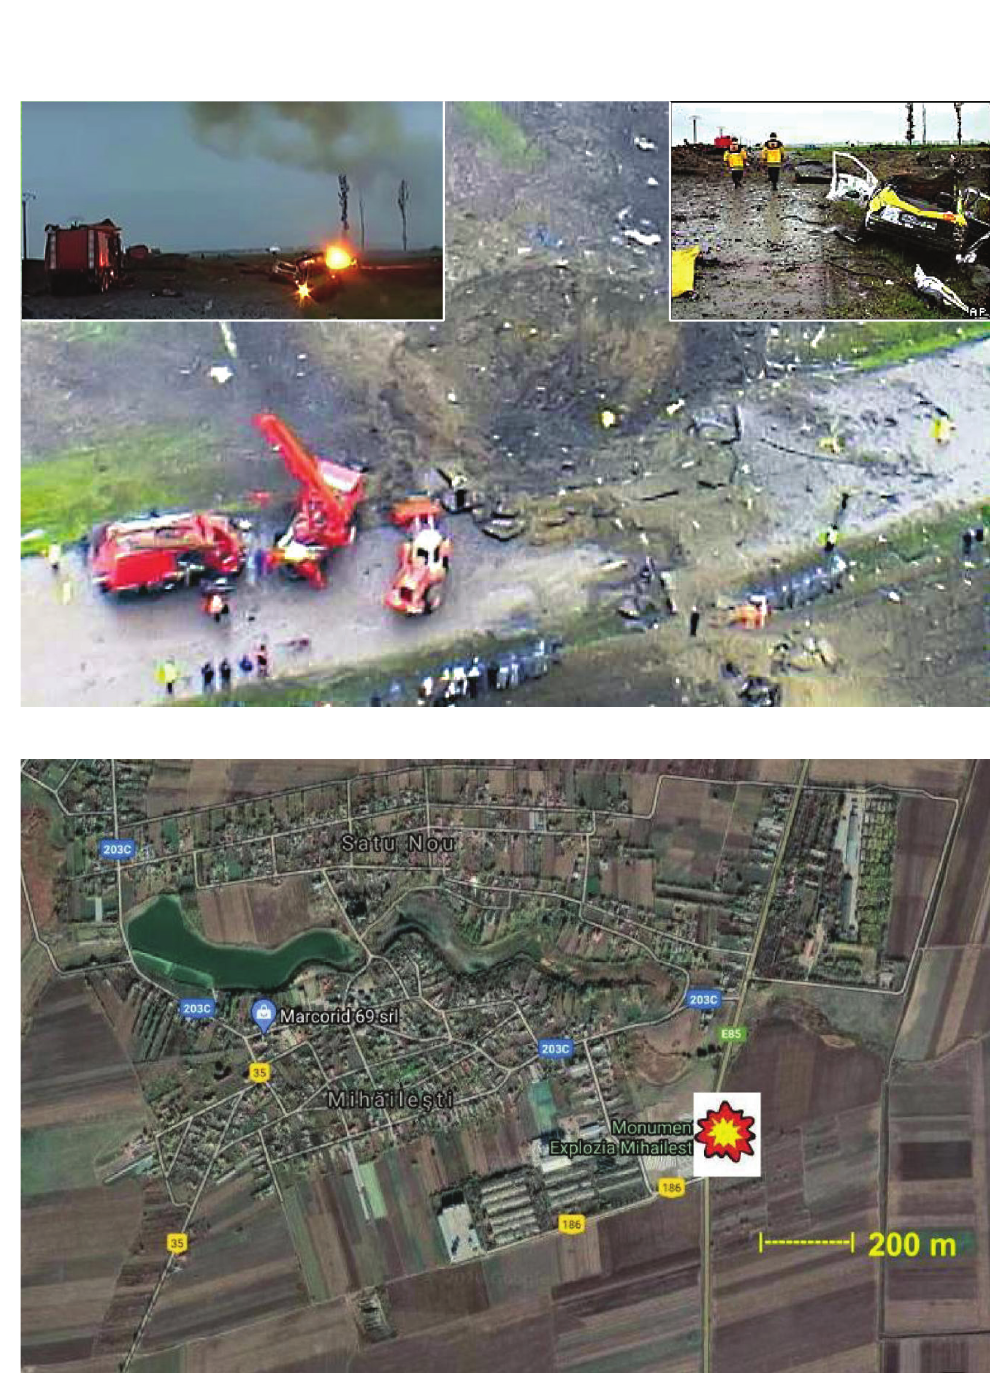
Fig. 1 – (a) Accident site after the explosion of the truck with AN near Mihăileşti village (Romania) on 2004. [Top left corner] A view of the explosion taken from a distance by an amateur (20 t AN exploded). [Top right corner] A view of some debris at the accident scene. Source: https://ade - varul.ro/locale/buzau/video-foto-explozia-mihailesti-plaseaza-buzaul-istoria-catastrofelor-ro - mania-1_51be28e2c7b855ff569aca3e/index.html (b) Accident site map next to Mihăileşti village (Romania). The explosion centre is marked with a yellow star (placed on the E-85 European road). Google-map Source: https://www.google.com/